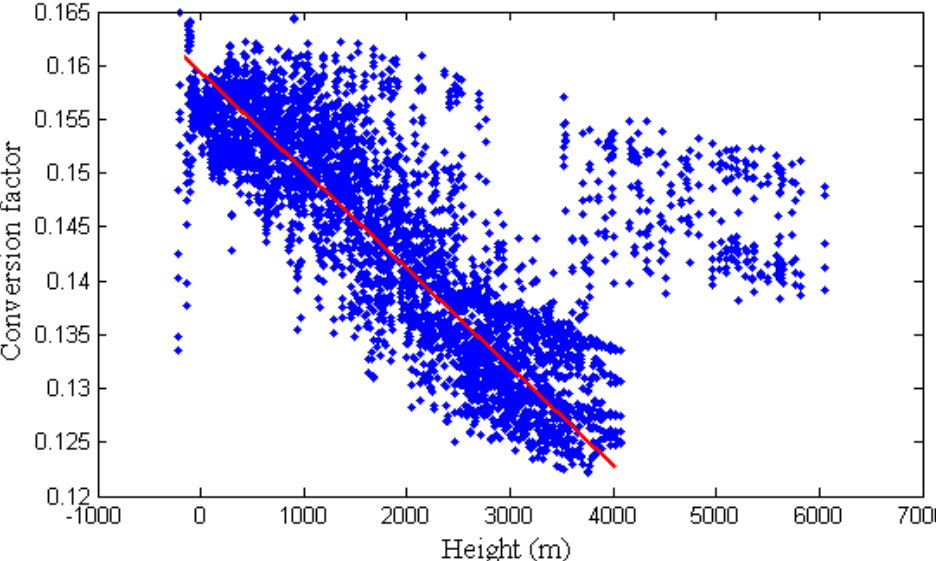
Figure 3. Relationship between the conversion factor and the elevation globally using the data from the year 2013.